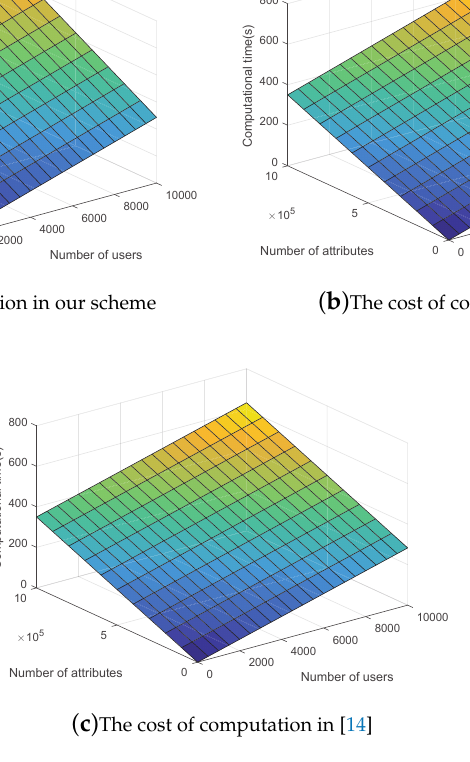
Figure 4. The computational cost